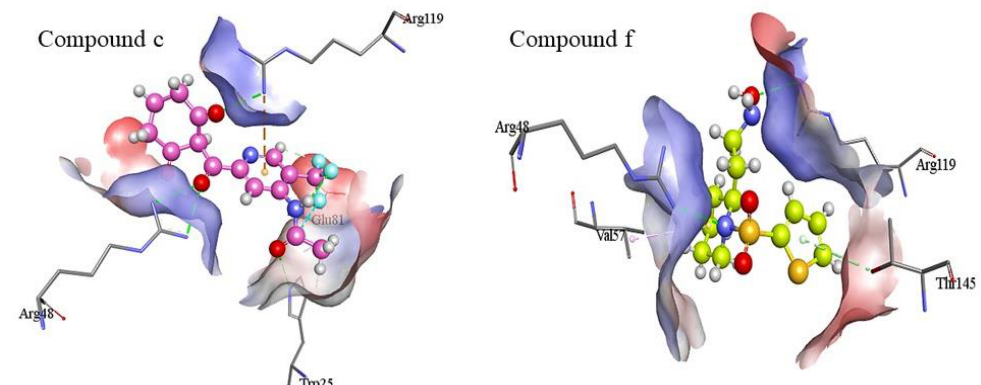
Figure 10. Visualization of ligand-protein interactions. Compounds c and f have demonstrated fa- vorable interactions with the active site residues of the target protein. The dotted lines represent the interactions between residues and ligand. Arg48 and Arg119 in the active pocket of the receptor have common interactions with both the ligands.